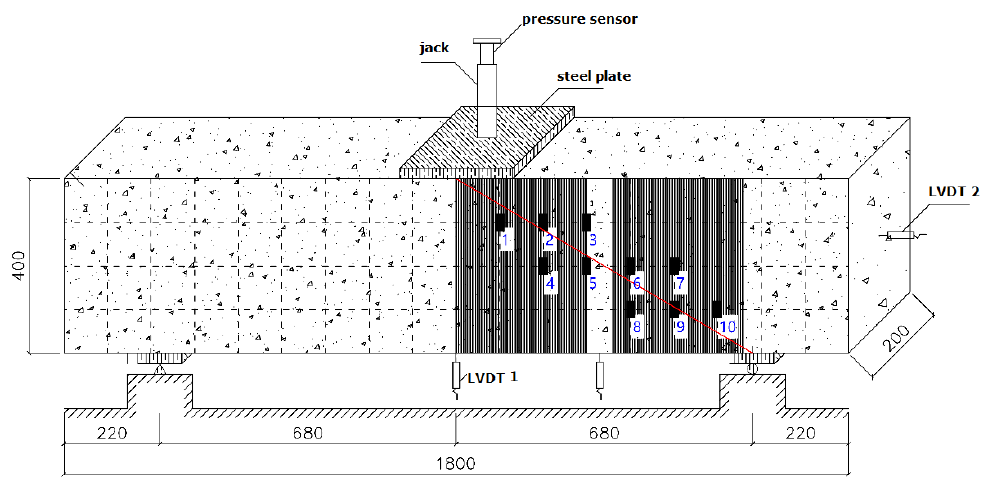
Figure 11. Strain gauges on the surface of flax fiber sheet (unit: mm).